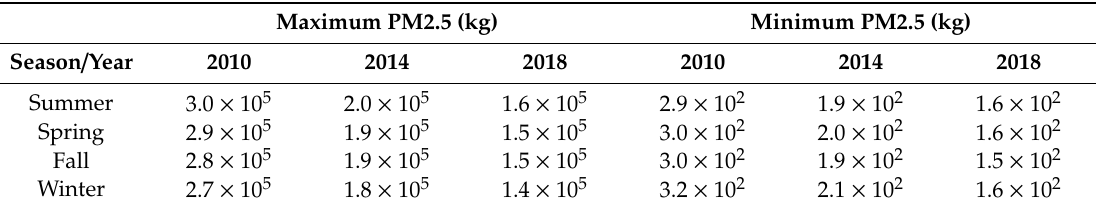
Table 1. County-level maximum and minimum seasonal PM2.5 in the state of California for years 2010, 2014, and 2018.